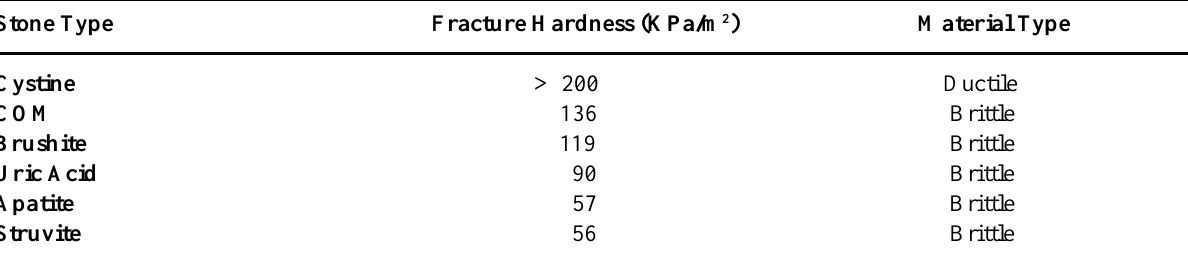
Table 1 - Fracture hardness of various types of urinary